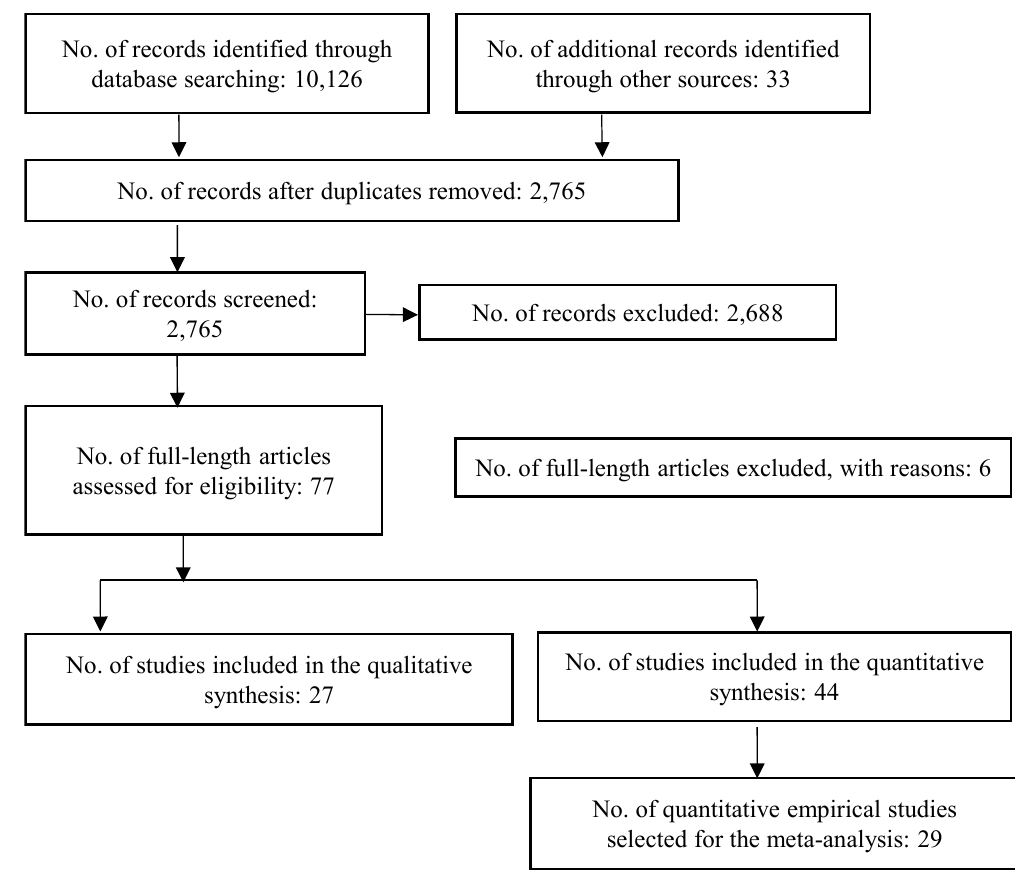
Figure 2. PRISMA Information Flow Chart.